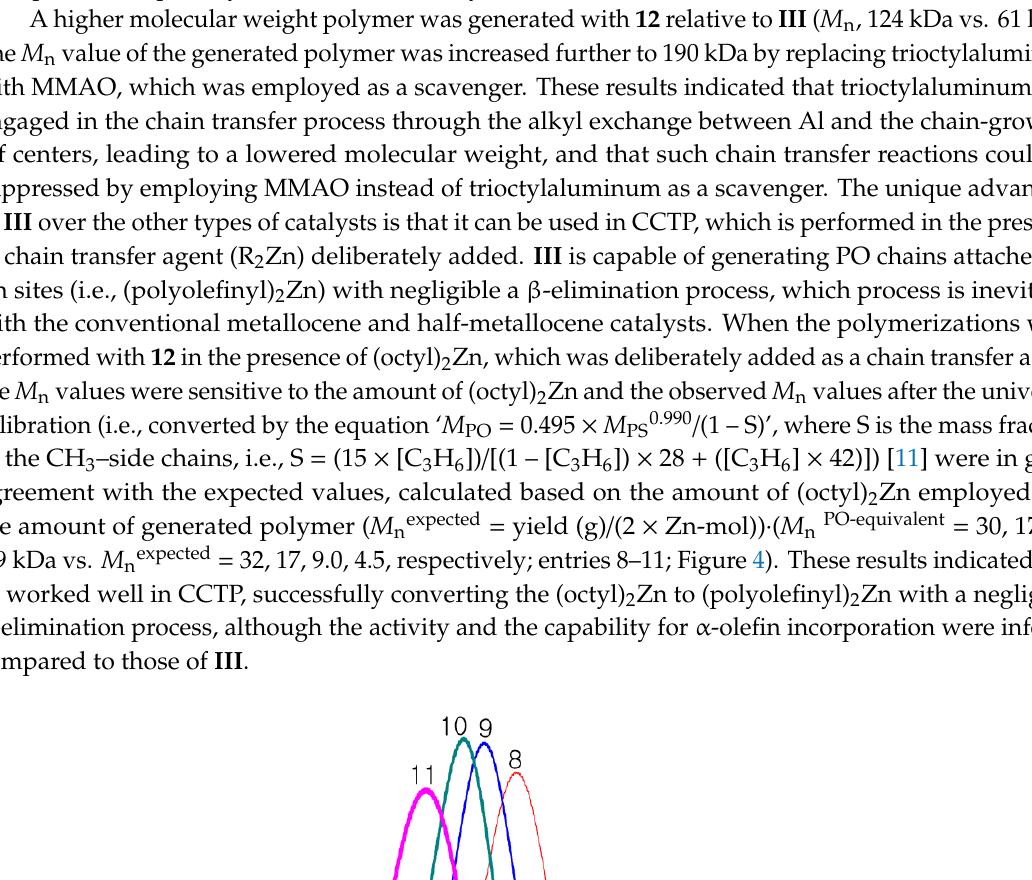
Table 1. Polymerization results a.